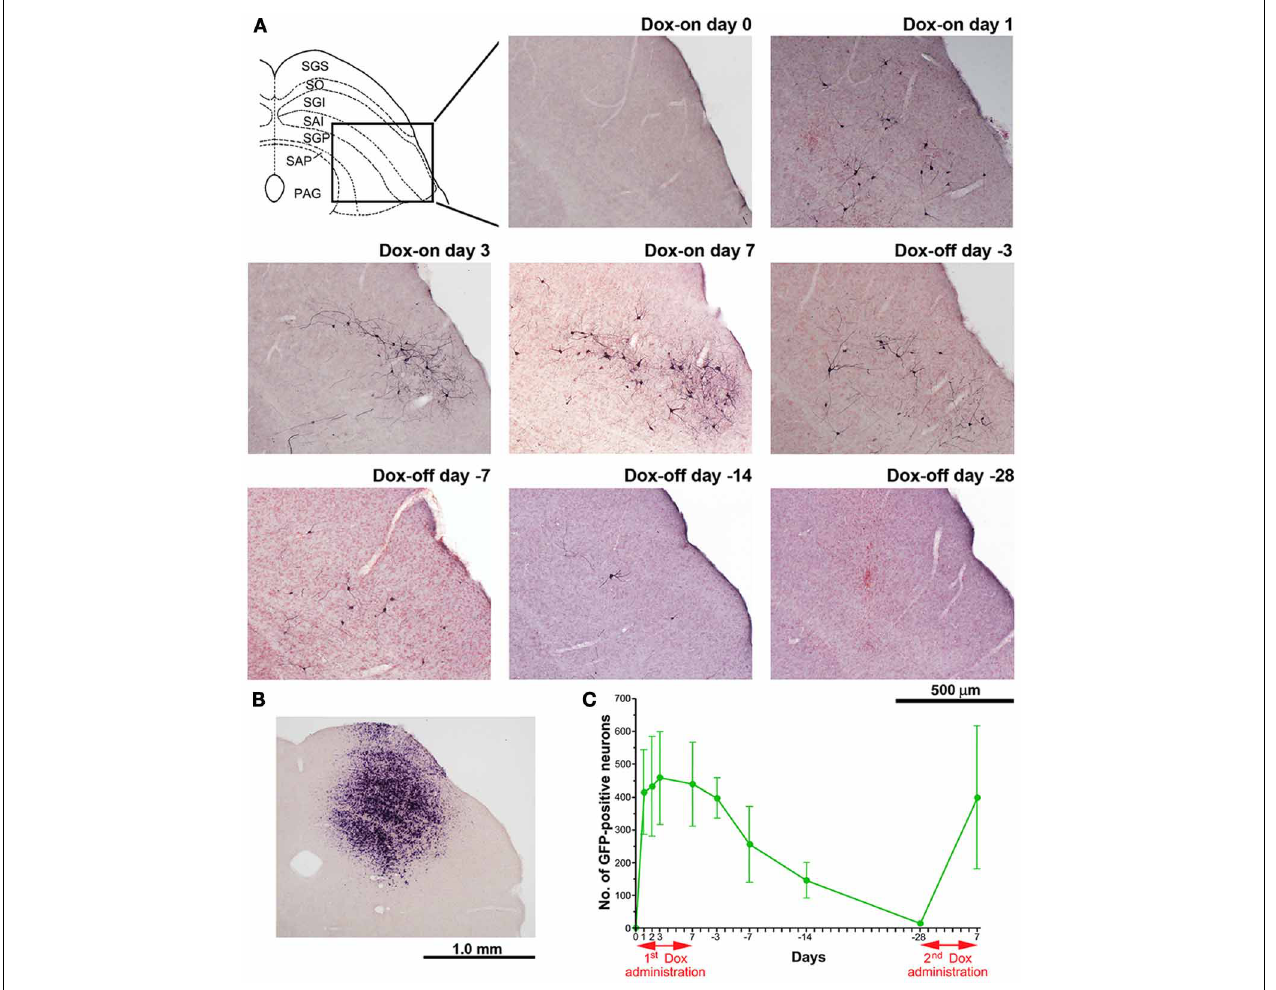
FIGURE 5 | Photomicrographs of GFP-positive cTRNs and in situ hybridization to visualize rtTAV16 in the superior colliculus (SC) of double infected mice. (A) Schematic diagram of the laminar structure of the mouse SC (frontal plane) and photomicrographs of the SC slices processed with anti-GFP immunohistochemistry (frontal section, inset area in the SC diagram), before Dox administration (Dox-on day 0), Dox administration for 1 day (Dox-on day 1), 3 days (Dox-on day 3), 7 days (Dox-on day 7), and after the termination of Dox administration for 3 days (Dox-off day − 3), 7 days